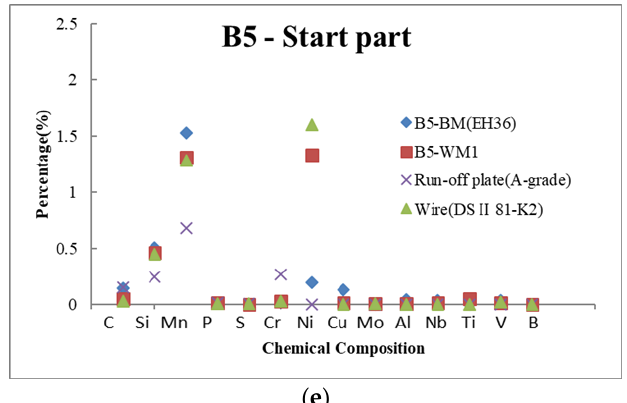
Figure 12. Results of chemical composition analysis of the weld joint for the removal of the run-off plate: ( a ) specimen B1-S and E; ( b ) specimen B2-S and E; ( c ) specimen B3-S and E; ( d ) specimen B4-S and E; and ( e ) specimen B5-S.